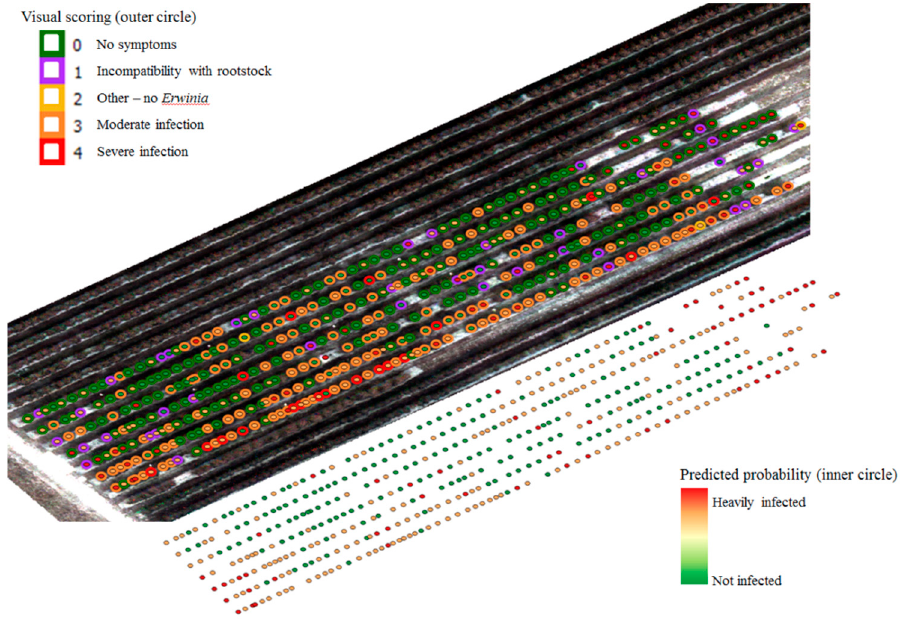
Figure 3. Probability of infection for each tree in the pear orchard calculated from the COSI-cam imagery acquired on 7 July 2015 (inner circle) overlaid on the visual scoring (outer circle). Red indicates high probability, while green corresponds to low probability of infection.